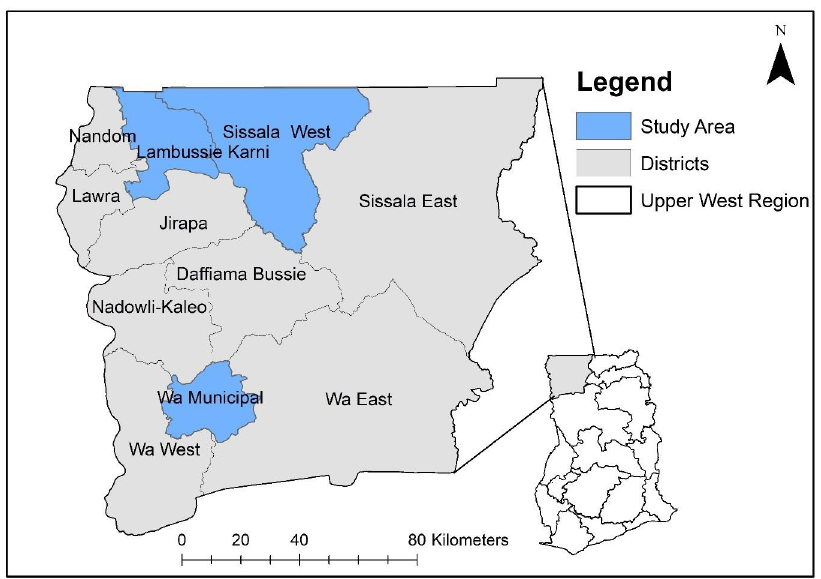
Figure 1. Case study area.